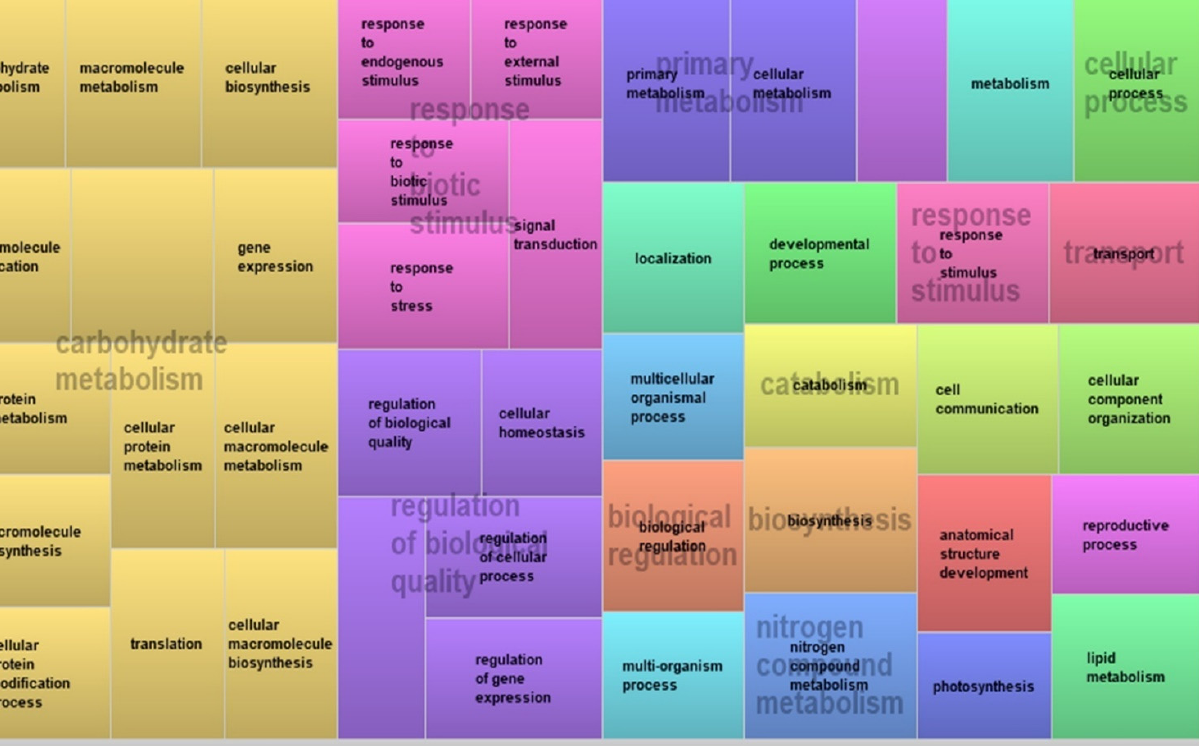
Figure 5. Annotation of DEGs in the R sorghum genotype at 360 h after sugarcane aphid infestation visualized with the reduced version of the plant gene ontology (REVIGO).